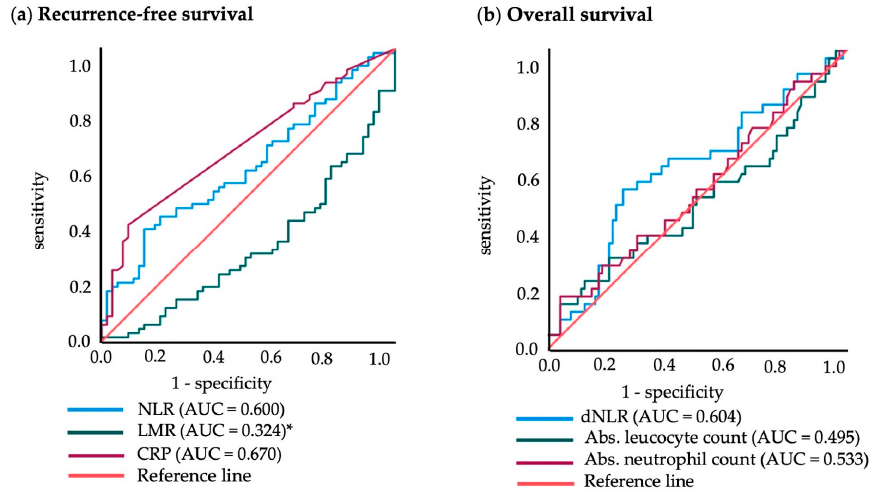
Figure 4. ROC curves for recurrence-free survival (RFS) and overall survival (OS) for dichotomization of blood values: ( a ) sensitivity and specificity with neutrophil-to-lymphocyte ratio (NLR); lymphocyte-to-monocyte ratio (LMR); C-reactive protein (CRP) for RFS survival; ( b ) sensitivity and specificity with derived NLR (dNLR), absolute leukocyte and neutrophil count for OS. (* Note: since the LMR negatively correlates to RFS, the ROC curve is below the reference line).